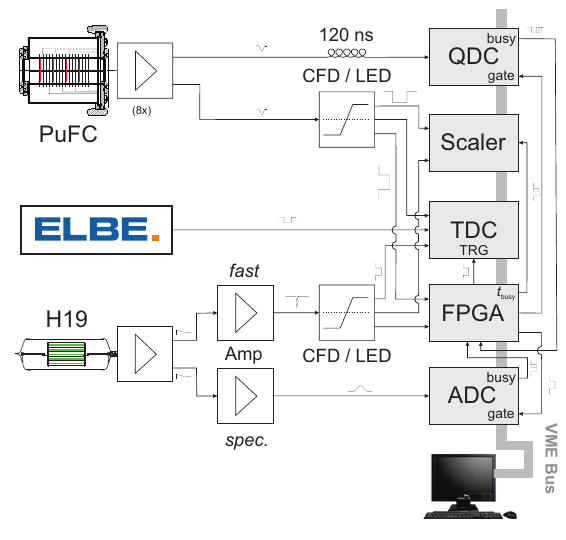
Figure 1. Scheme of the electronic setup and the data acquisition system. The output signals of the charge- sensitive (ns-) preamplifiers connected to the PuFC are split to determine the timing and the collected charge. The pulse heights of the H19 signals are acquired with an ADC after getting shaped by a spectroscopic amplifier, whereas the charge of the eight PuFC channels (only one is shown here) is determined by a QDC. The second output signal is converted to a logical signal by an in-house developed constant fraction discriminator (CFD). The production of a fast trigger makes the use of a timing-filter-amplifier in the fast branch of the H19 necessary. The logical signals are used to determine the timing in a time-to-digital converter (TDC) and to produce a trigger for the data acquisition in an FPGA. The radio-frequency of the ELBE accelerator is used as reference for the time-of-flight